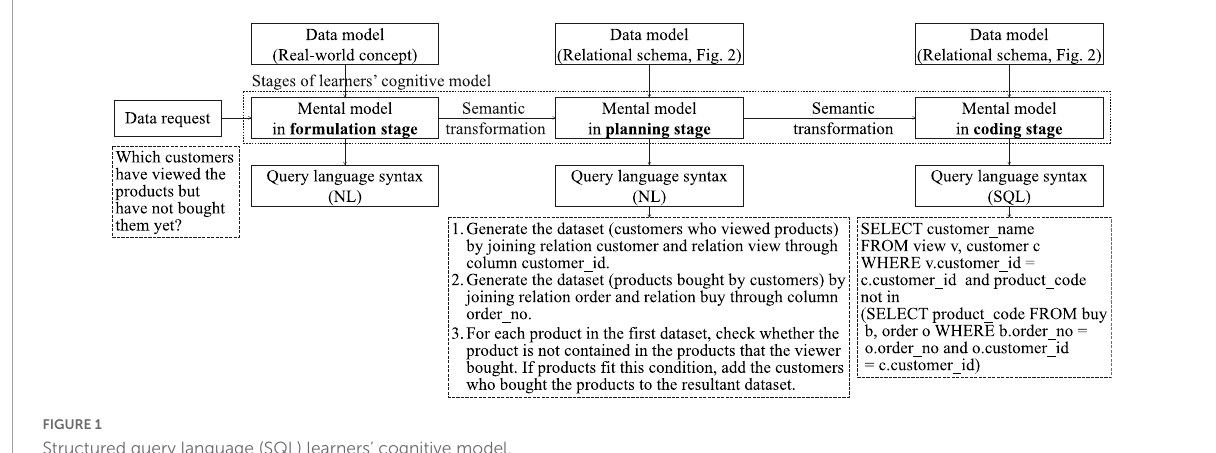
FIGURE1 Structured query language (SQL) learners’ cognitive model.